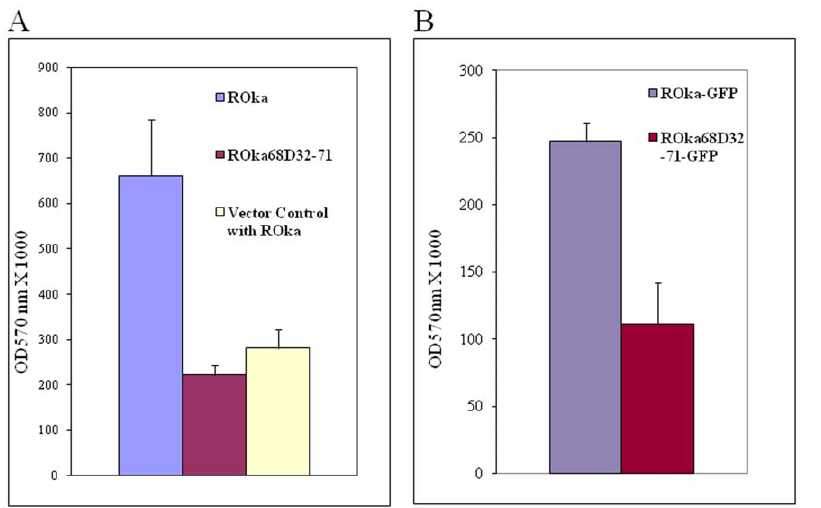
Figure 7. VZV mutant lacking the IDE binding domain of gE shows reduced fusogenicity by membrane fusion assay. (A) Melanoma cells expressing T7 polymerase were infected with VZV ROka, ROka68D32-71, and the cells were incubated with HeLa cells containing the b – galactosidase gene driven by the T7 promoter or a control GFP plasmid for 20 hr. The cells were lysed, incubated with chlorophenol red- b -D- galactopyranoside, and b –galactosidase activity was measured using a spectrophotometer at OD570 nm. The experiment was also performed at 16 hr and 24 hr and similar results were obtained. Vertical lines indicate standard deviations. (B) Human melanoma cells expressing T7 polymerase were infected with the same MOI of ROka-GFP or ROka68D32-71-GFP, and cells were co-incubated with HeLa cells containing the b –galactosidase gene driven by the T7 promoter for 16 hrs. The cells were lysed, incubated with chlorophenol red- b -D-galactopyranoside, and b –galactosidase activity was measured using a spectrophotometer at OD570 nm. The experiment was performed twice with similar results. (P , 0.001 for ROka-GFP vs.